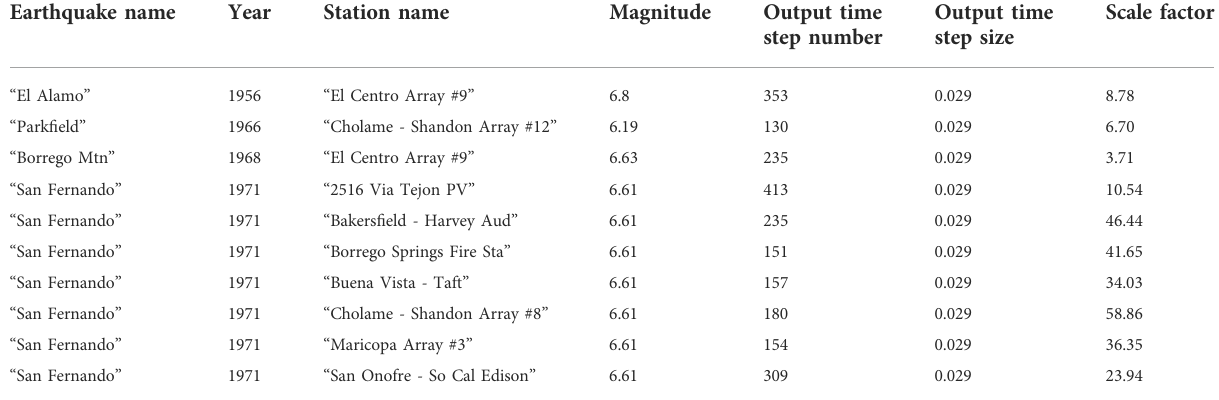
TABLE 5 Characteristics of earthquakes